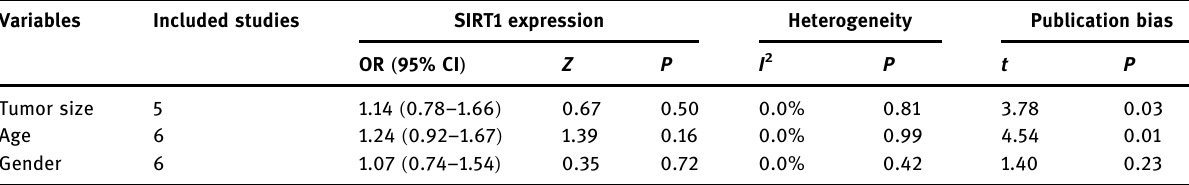
Table 2: Meta - analysis of SIRT1 expression and tumor size, age, and gender of ESCC Variables